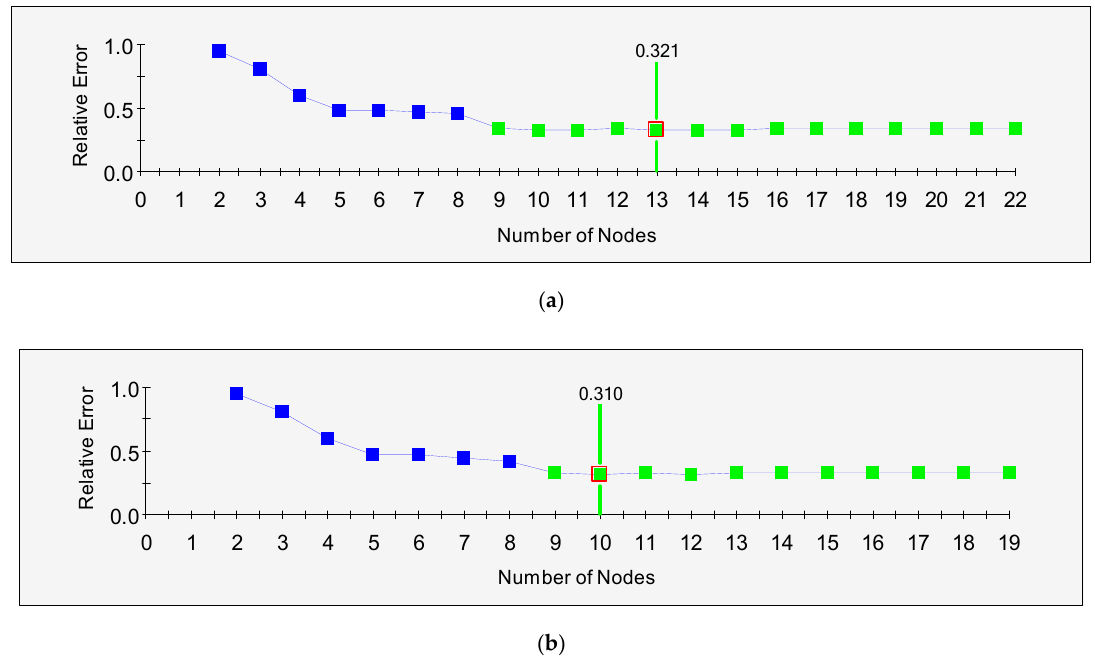
Figure 3. Relative error of the constructed classification and regression tree (CART) models depending on the number of terminal nodes: ( a ) m1 = 5, m2 = 2; ( b ) m1 = 6, m2 = 3. Table 3. Summary statistics of the selected regression CART models for assessment of students’